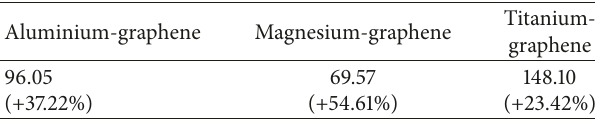
Table 2: Nanocomposite Young’s modulus [GPa]. 𝑤 GNP = 5 %.